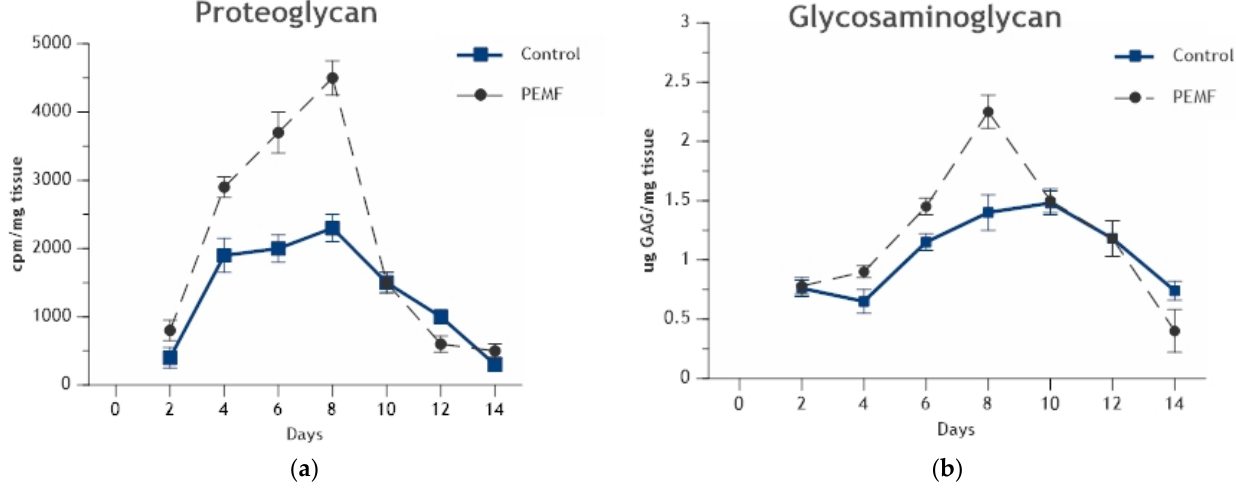
Figure 7. ( a ) Incorporation of radiolabeled sulfate into proteoglycan. Ossicles exposed to PEMF displayed a significant increase in proteoglycan synthesis by day 4 of ossicle development, peaking during maximal chondrogenesis on day 8 ( p = 0.001) and falling to control levels coincident with the onset of calcification. ( b ) Glycosaminoglycan content. Ossicles exposed to PEMF exposure exhibit increases in glycosaminoglycan content during chondrogenesis (days 4–8) ( p = 0.05 on day 6 and p = 0.01 on day 8). With the onset of calcification on day 10, cartilage matrix is resorbed in both control and PEMF-exposed ossicles [64] .